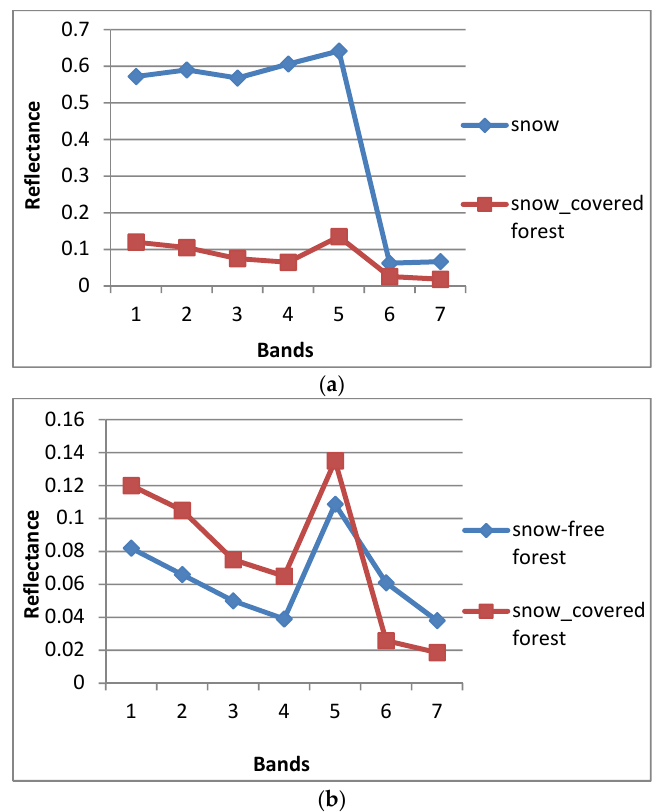
Figure 3. Optical properties of snow, snow-covered forest, and snow-free forest. ( a ) The optical properties of snow and snow-covered forest; ( b ) the optical properties of snow-free forest and snow-covered forest.